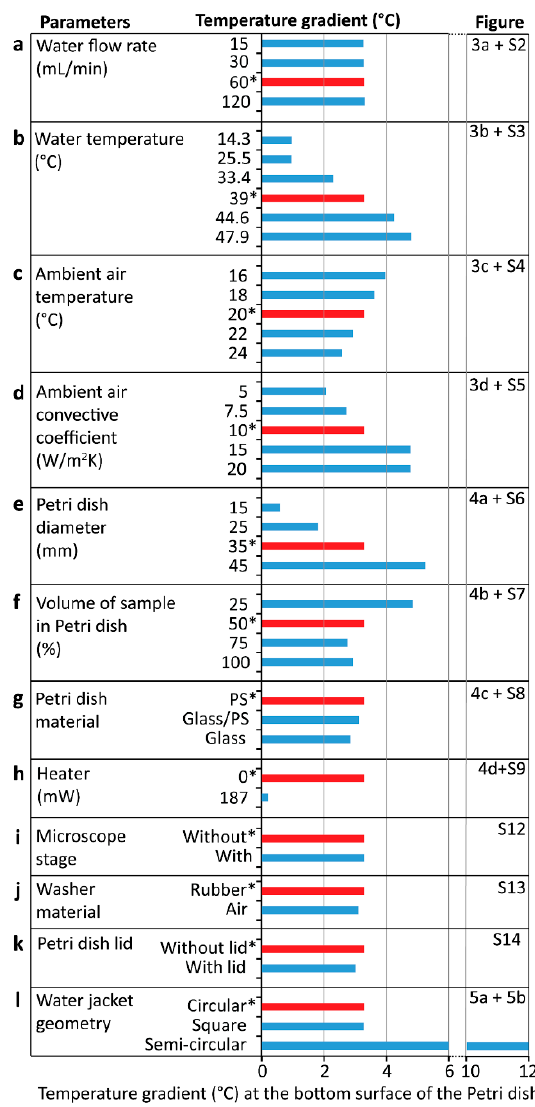
Figure 6. Comparison of temperature gradients along the bottom surface of the Petri dish under different conditions, obtained by numerical simulations. The reference conditions presented in Figure 2 are shown with * symbol. ( a ) Flow rate of water recirculating through the water jacket ( Q water ). ( b ) Temperature of water entering the water jacket ( T water ). ( c ) Ambient temperature ( T air ). ( d ) Convective coefficient of ambient air ( h air ). ( e ) Diameter of Petri dish ( D Petri dish ). ( f ) Sample volume stored in Petri dish ( V sample ). ( g ) Thermal conductivity of Petri dish by replacing polystyrene with glass. ( h ) Placing a heater element underneath the Petri dish. ( i ) Placing the water jacket system on a microscope stage. ( j ) Thermal conductivity of the gap between the water jacket and the Petri dish by inserting a rubber washer. ( k ) Covering the Petri dish with a polystyrene lid. ( l ) Changing the geometry of the water jacket from circular to a square or semi-circular configuration.